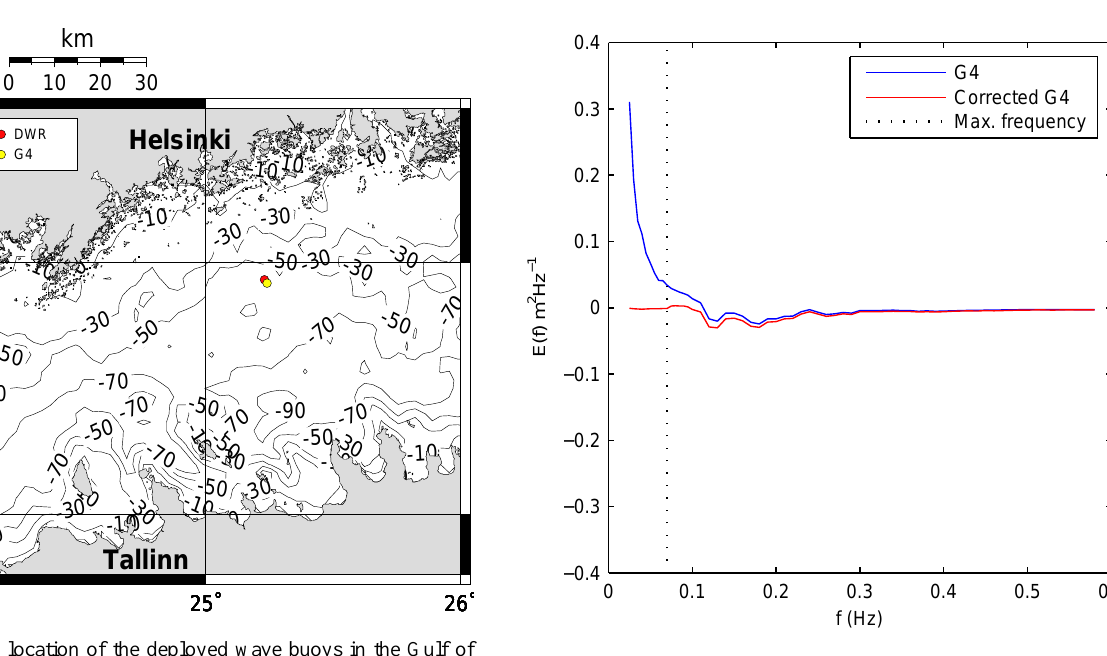
of the correction method in a logarithmic histogram (Fig. 6).